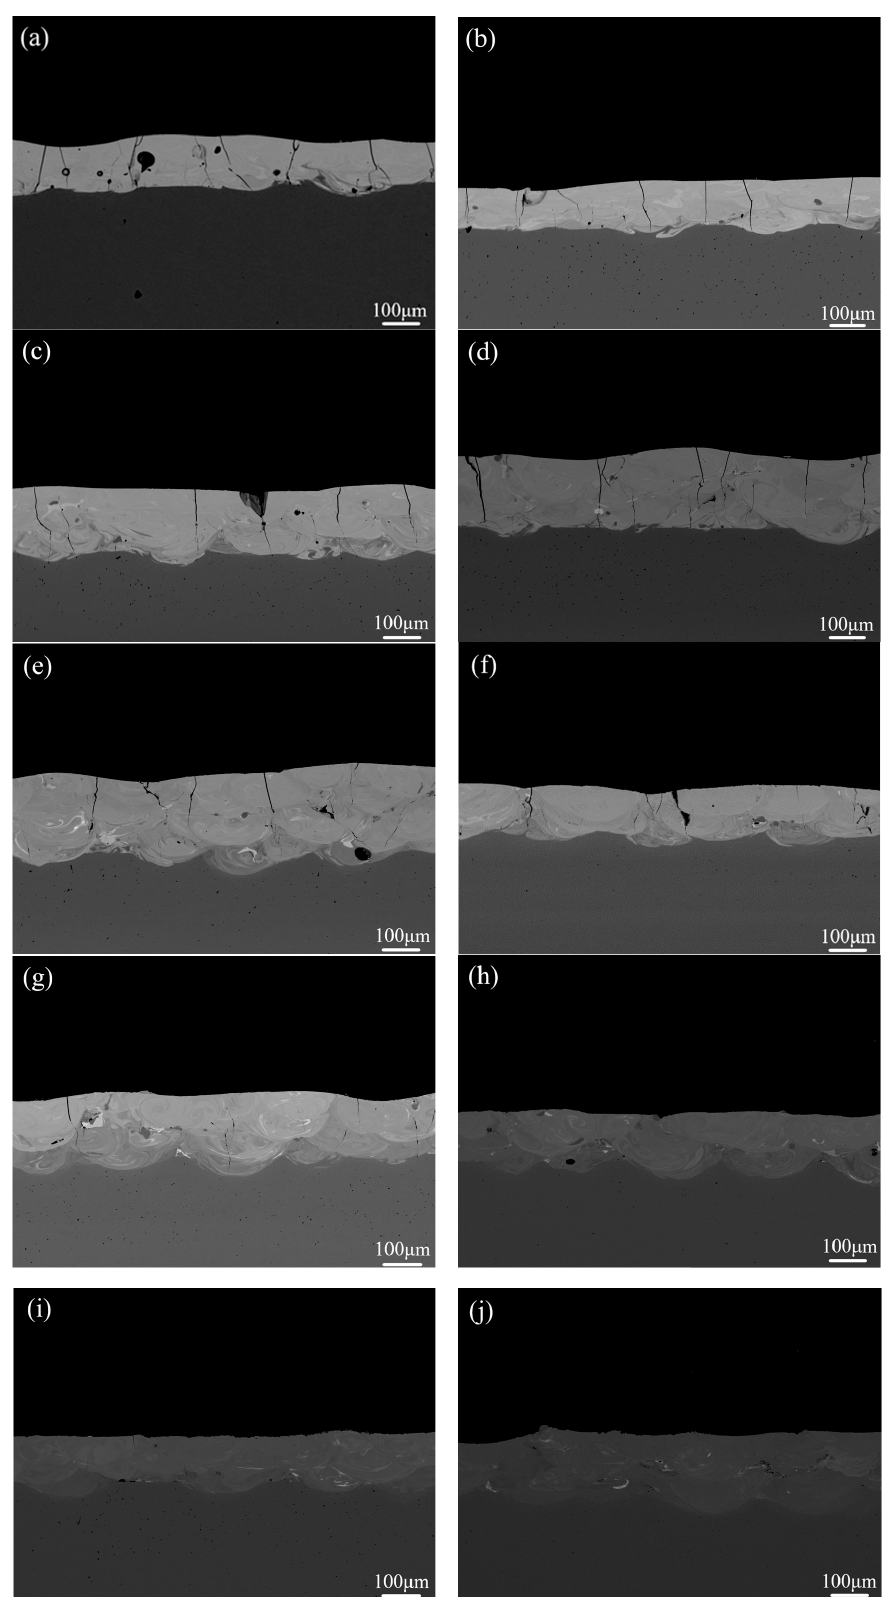
Figure 7. XRD patterns of the Co-based amorphous coating and the composite coatings produced by laser-cladding the mixtures of Co 55 Ta 10 B 35 amorphous powder with different contents of Fe powder.